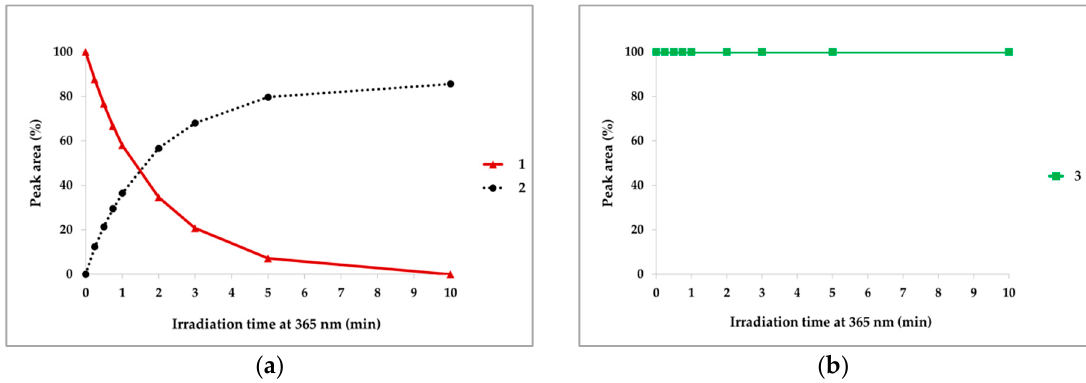
Figure 4. UV stability of the parent VEGFR-2 inhibitors. The compounds were irradiated at 365 nm with 5.4 W for up to 10 min and analyzed time dependently by HPLC. The detection wavelength for the HPLC analysis was 300 nm. The area under the HPLC-peaks is plotted against the irradiation time. ( a ) Irradiation of 1 mM solution of 1 in DMSO (red line). By progressing irradiation, 1 is converted into the intermediate product 2 (dotted black line); ( b ) Irradiation of 1 mM solution of 3 in DMSO (green line). 3 is stable under the described UV irradiation.